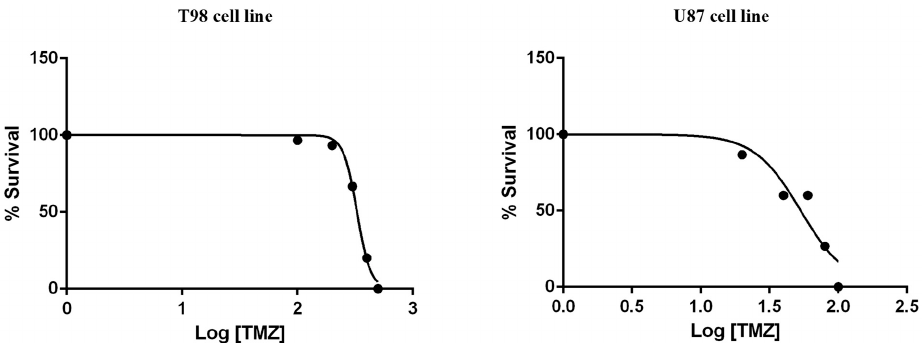
Figure 4. Cytotoxic effect of TMZ on T98 and U87 cell lines, 72 h after treatment. Values represent the means of three independent experiments and are normalized to non-treated cells. The non-linear regression analysis methodology of GraphPad Prism Version 6 was used to determine the IC50 values.